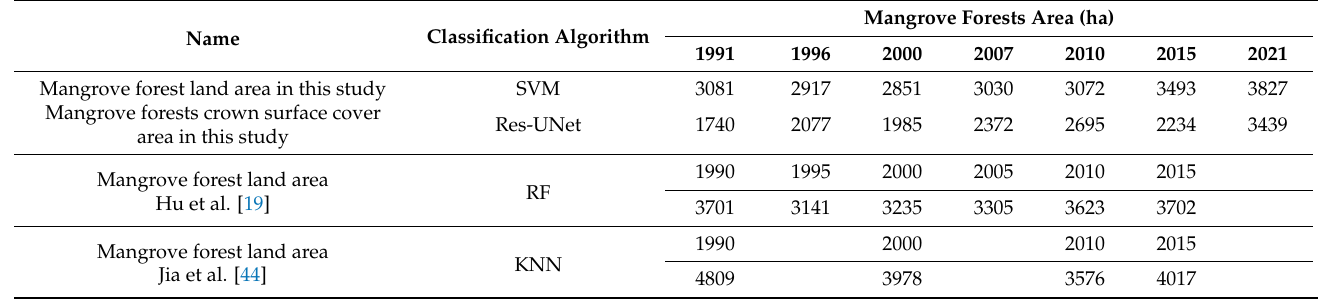
Table 8. Comparison of mangrove forest areas in the Hainan Island among different